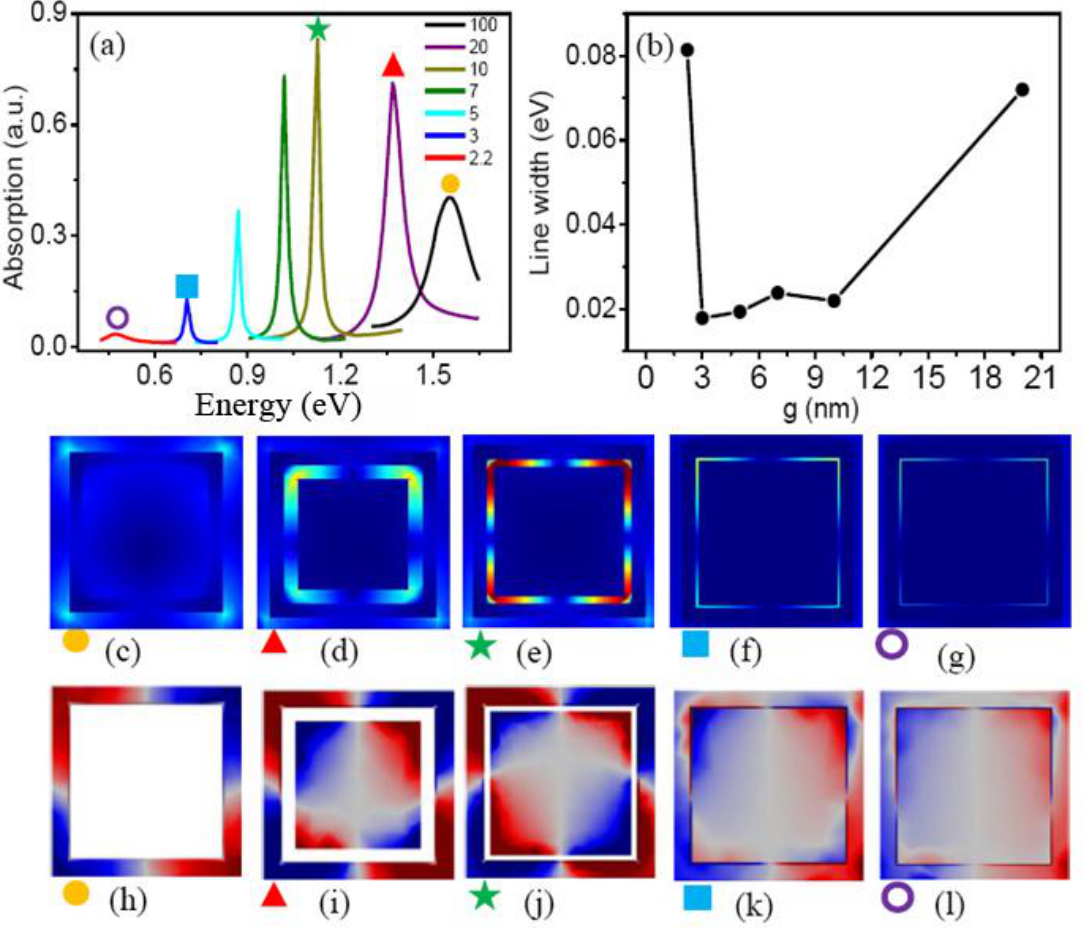
Figure 5. ( a ) The absorption spectra of the CSRD with different gap width g ; ( b ) The line widths of Fano dips as a function of the gap width g ; ( c – g ) The electric field distribution in the middle section and ( h – l ) the induced surface charges on the top surfaces at the quadrupolar resonance peaks in ( a